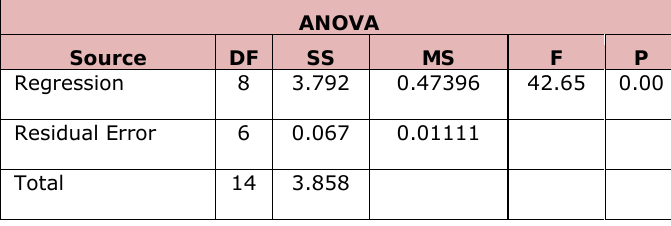
Table 2. “Summary of Coefficient Analysis”.